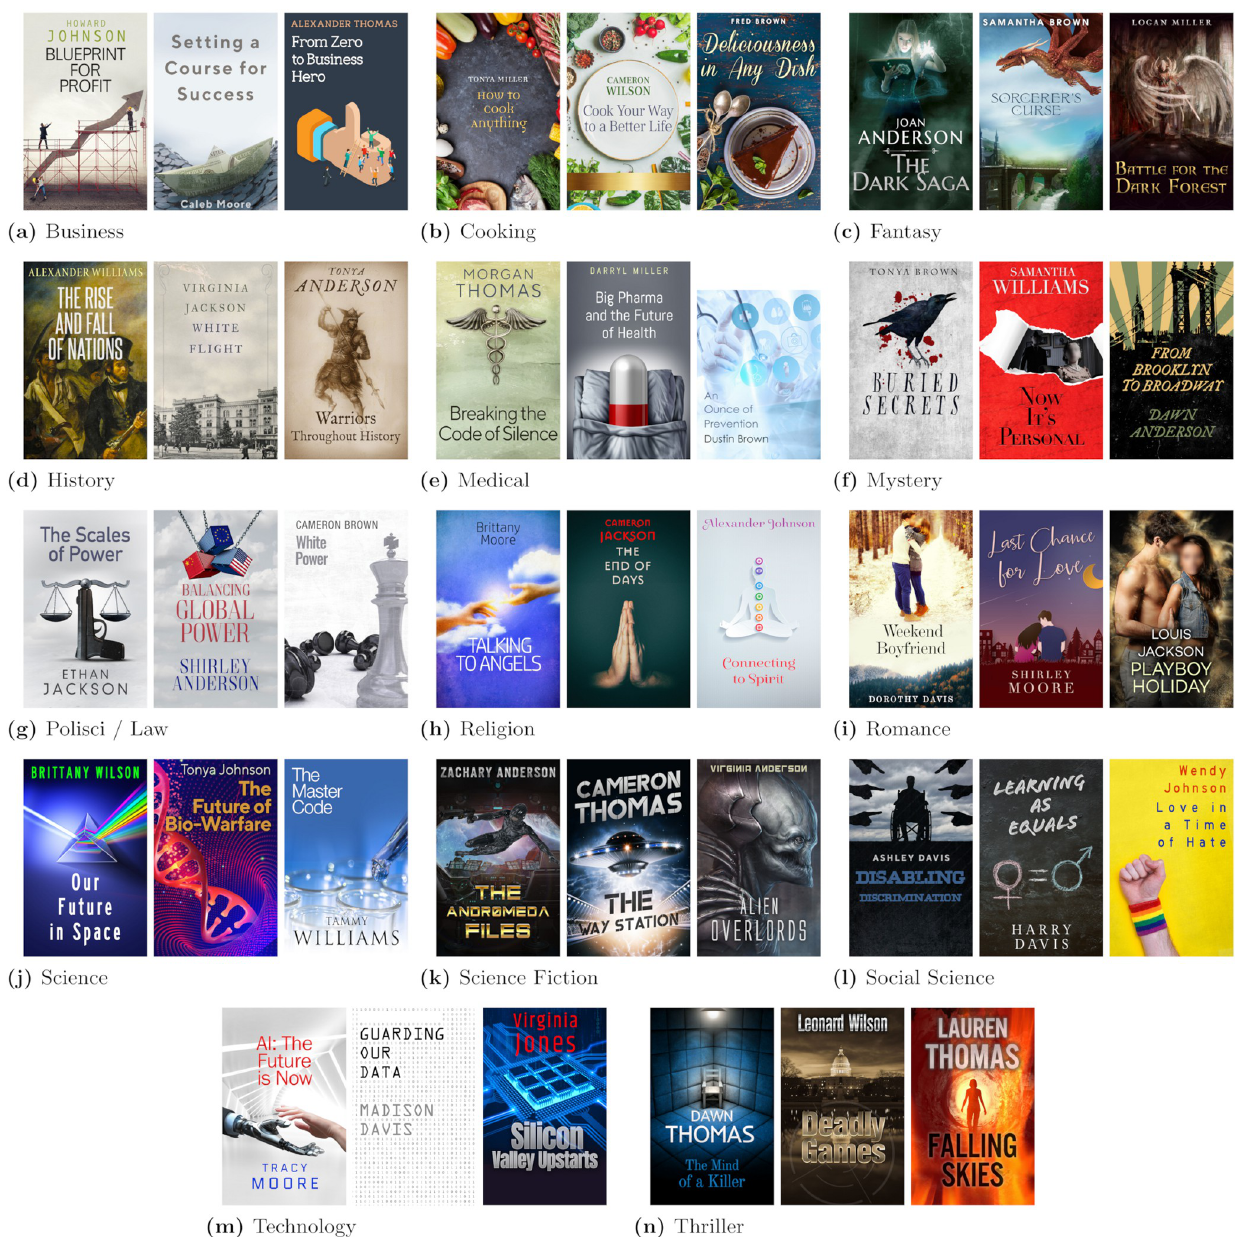
Fig 1. Cover art. The 42 cover art images used for the book cover manipulation with sample title and author combination selected at random to be displayed here. All covers are printed under a CC BY license with permission from Book Cover Zone, original copyright 2019. Faces in photos are blurred if they are potentially